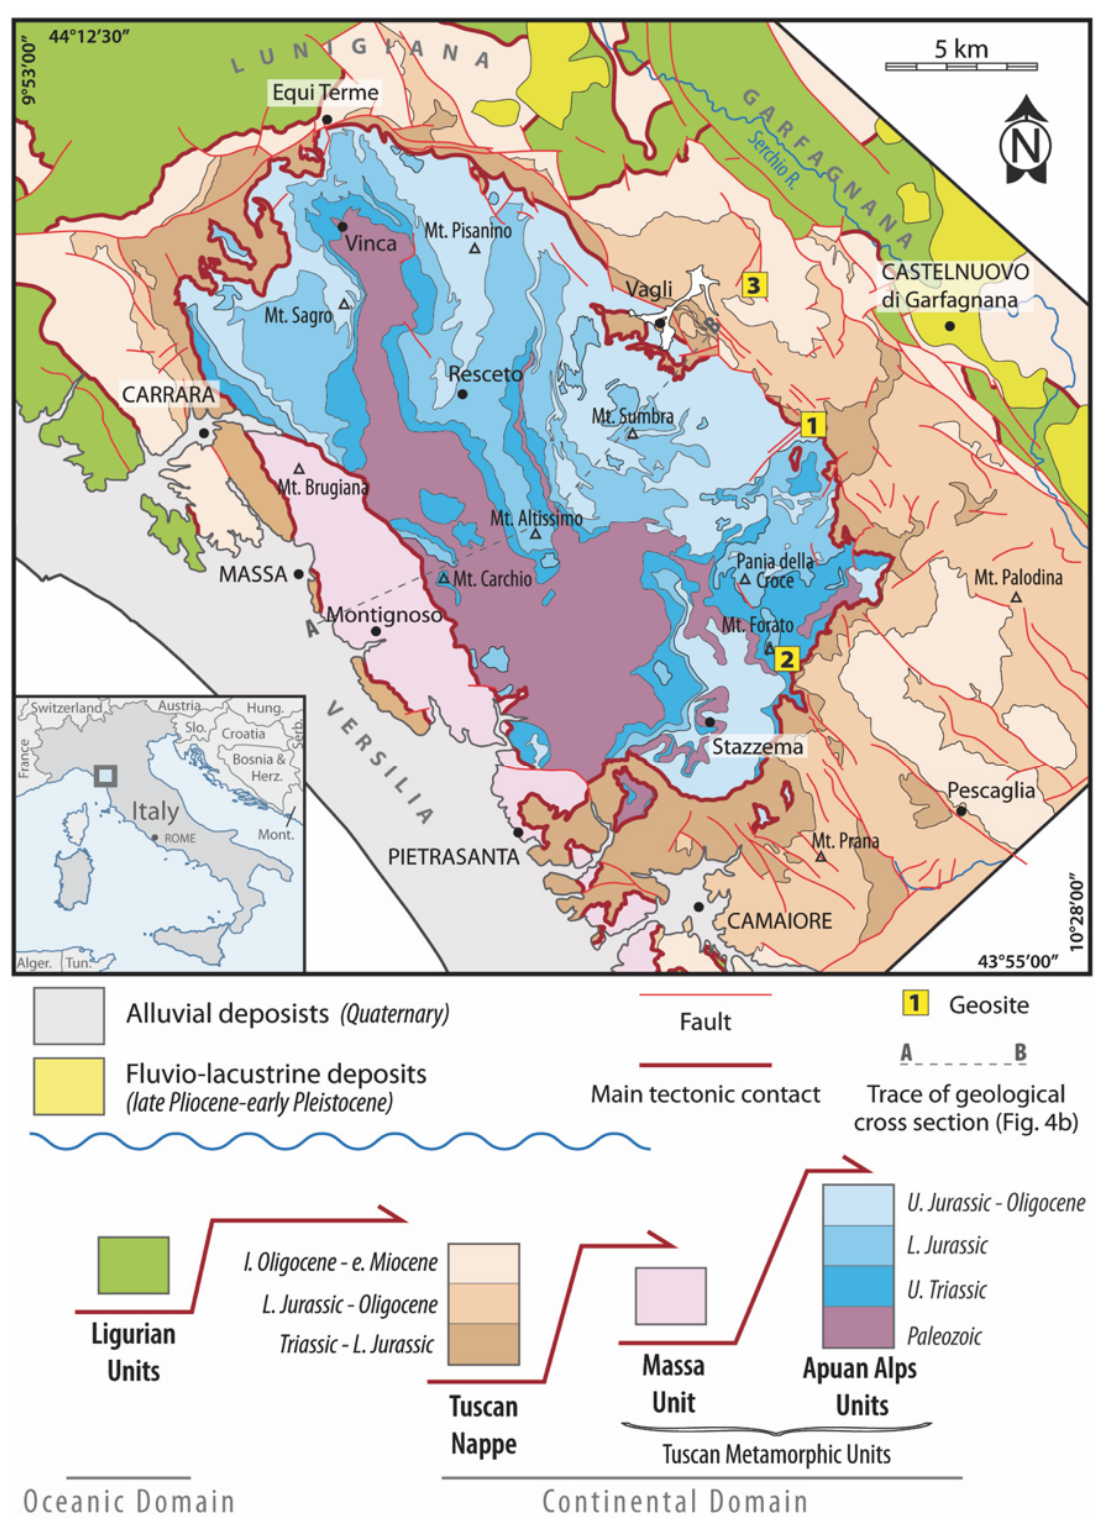
Figure 1. Geological sketch map of the Apuan Alps (modified after Carmignani and Kligfield, [30]) and location of the presented geosites.